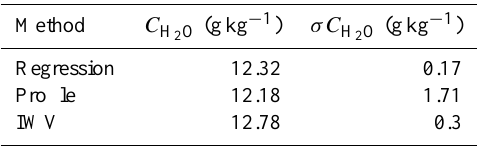
Table 1. Calibration factors and errors of the regression, profile and IWV method.